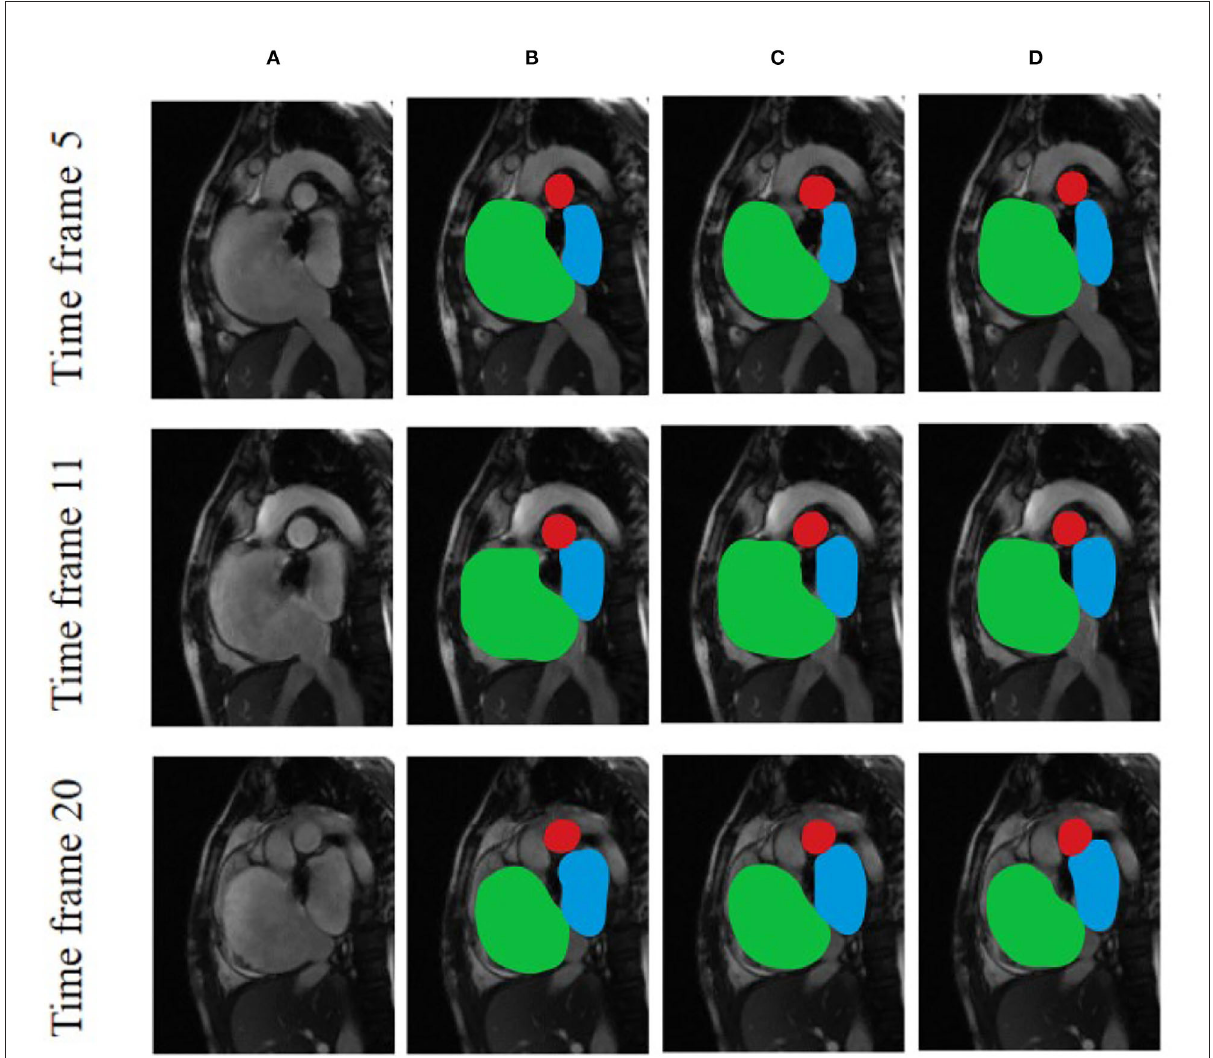
FIGURE6 Comparison of the effects of different segmentation models using various cardiac MRI slices based on (A) Original and unprocessed images; (B) ESA-UNet; (C) UNET; and (D)